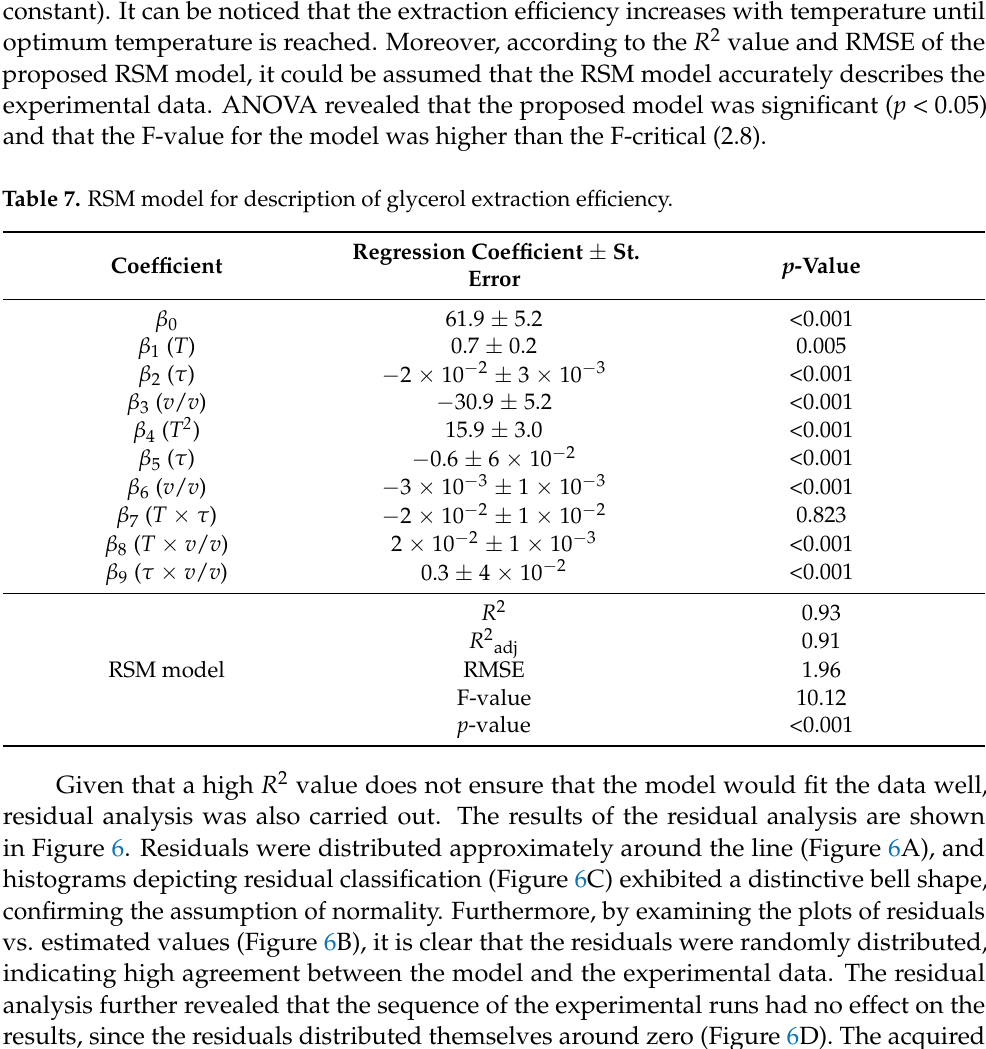
Table 7. RSM model for description of glycerol extraction efficiency. Coefficient